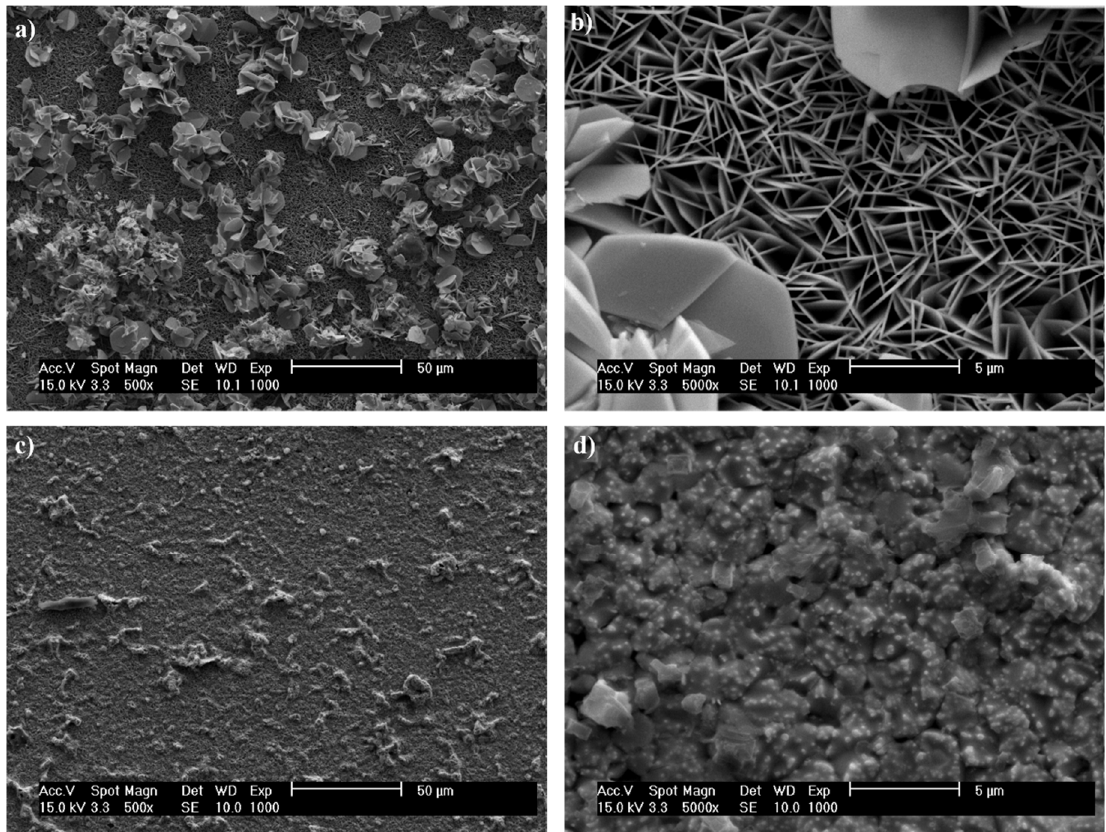
Figure 3. The surface morphology of the upper layer of the heterojunction with: ( a ) and ( b ) plumbonacrite film, ( c ) and ( d ) PbSe film.